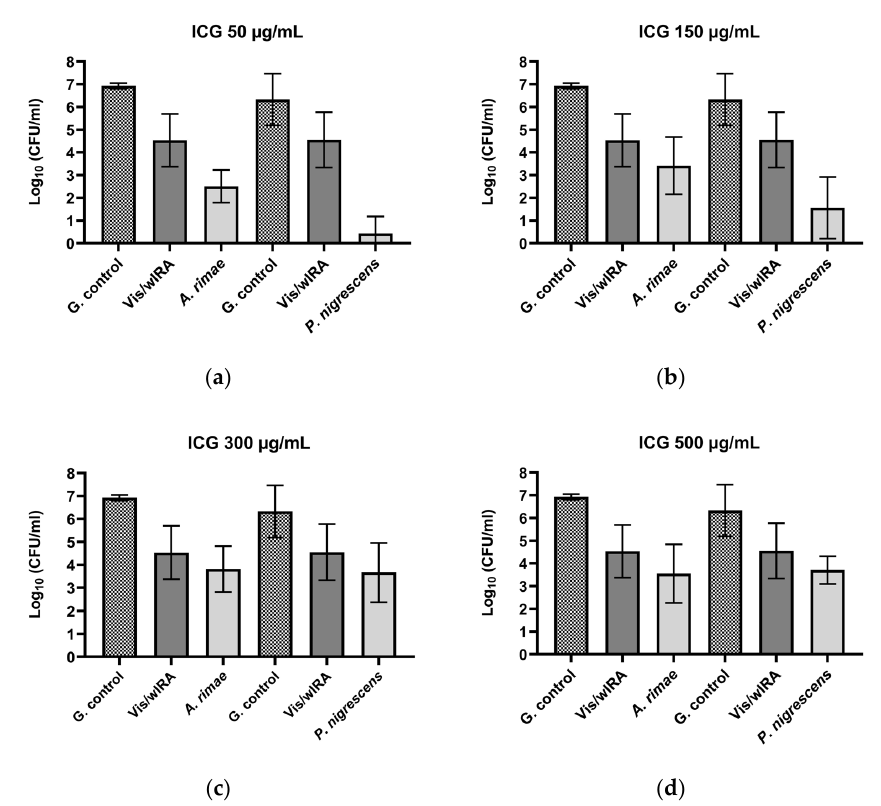
Figure 3. Photodynamic efficacy of ICG in combination with Vis + wIRA against A. rimae and P. nigrensces . ICG was tested at concentrations of ( a ) 50 µ g/mL, ( b ) 150 µ g/mL, ( c ) 300 µ g/mL, and ( d ) 500 µ g/mL. The CFU numbers are given on a log 10 scale per milliliter (log 10